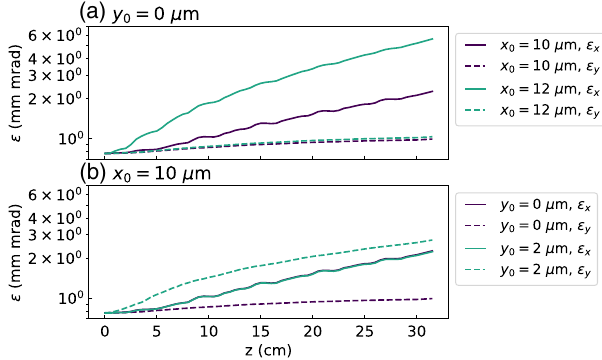
FIG. 9. Growth of slice emittance ϵ x and ϵ y in both transverse directions x and y along propagation in the presence of laser pulse and electron beam misalignments from W arp simulations. The simulation conditions are given in Table I. The laser pulse initial position is ¯ x 0 ¼ 10 μ m. (a) Two electron beams start with X 0 ¼ 10 μ m and X ¼ 12 μ m, respectively, with Y ¼ 0 μ m. The ϵ 0 0 y emittance is the same for both beams. (b) shows the same result for beams with the same X 0 ¼ 10 μ m and with Y 0 ¼ 0 and 2 μ m, respectively. In this case, both beams have the same ϵ x emittance